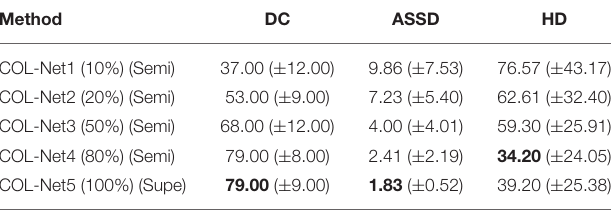
TABLE 1 | The results of different strategies on the SPES